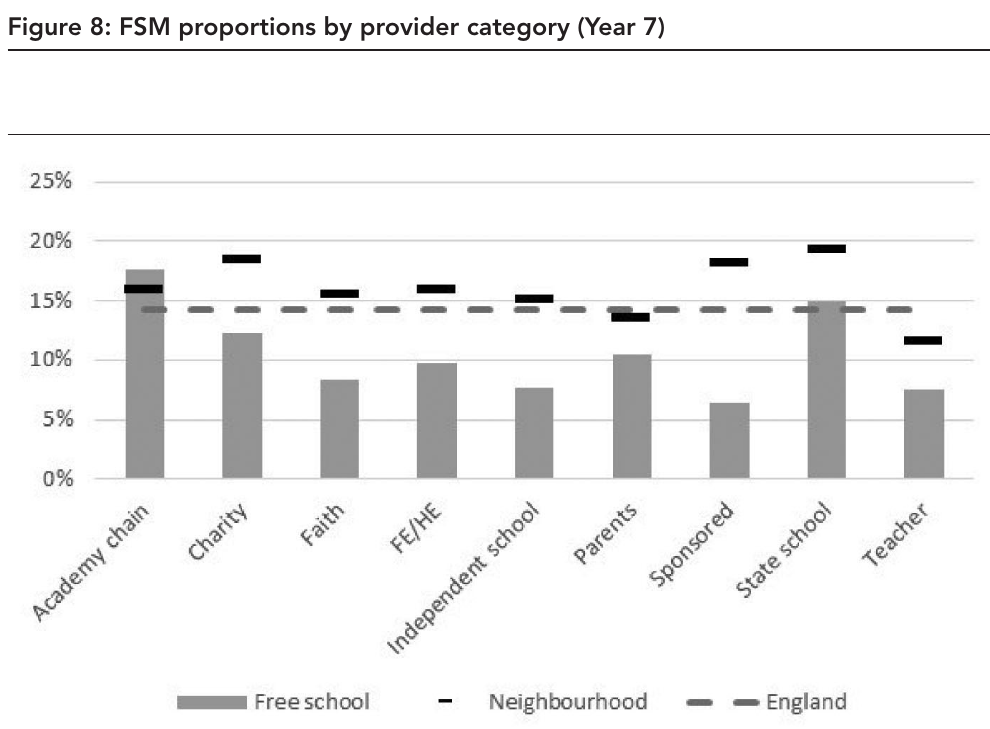
Figure 9: FSM proportions by provider category (Year